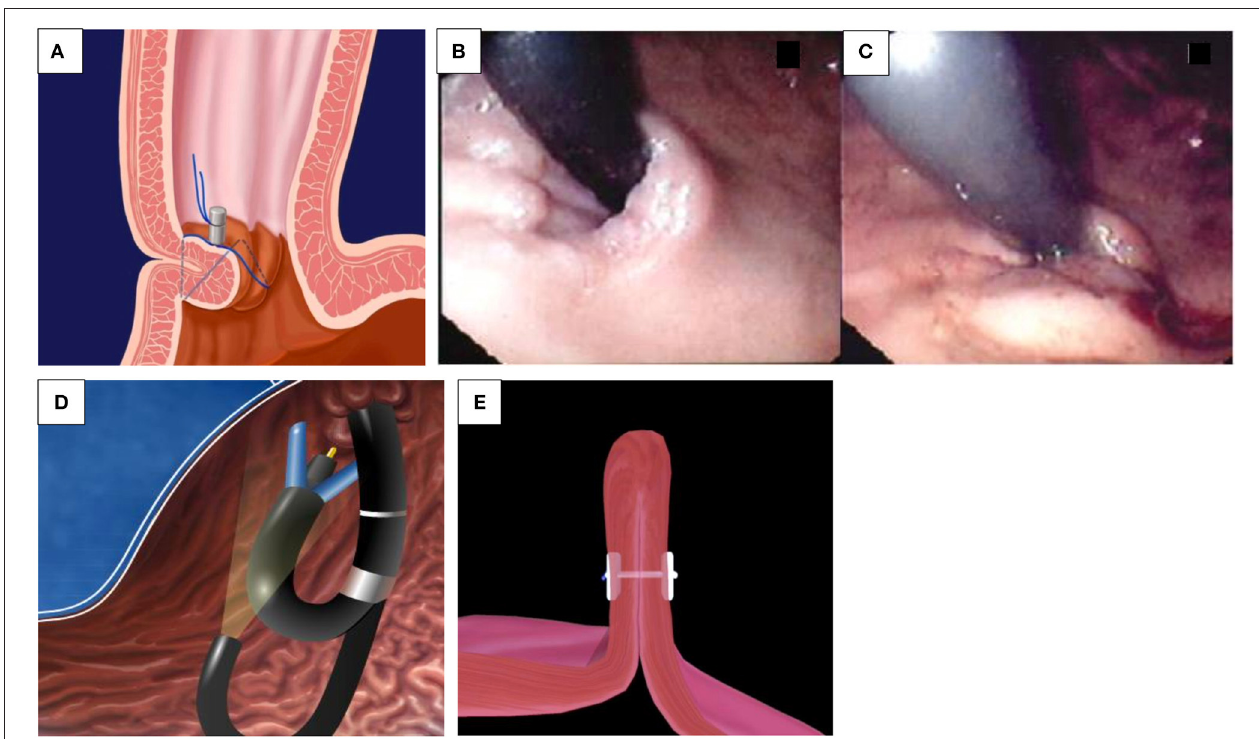
FIGURE 6 | (A–E) Endocinch ® and full thickness Plicator ® (Ndo-Surgical). (A) Endoscopic gastroplication with a zig-zag stich when applied with an Endocinch ® sewing maching. (B,C) View (J maneuver) of a lax GO junction in a child with major reflux before (A) and after (B) application of stitch with the EndoCinch ® . (D) Application of a full Thickness Plicator ® (Ndo-Surgical). (E) After application of the full Thickness Plicator ®